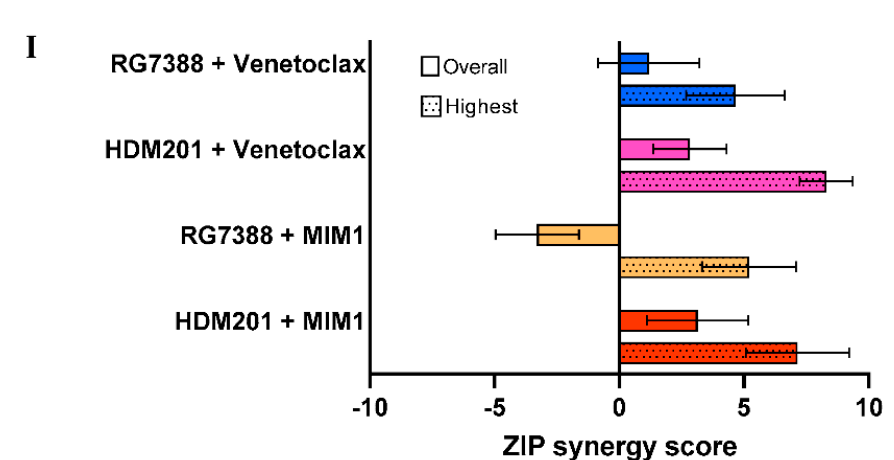
Figure 10. Dose–response curves for single agents, dose–response matrices (inhibition) and syn- ergy maps generated using SynergyFinder for ( A , B ) Venetoclax and RG7388; ( C , D ) Venetoclax and HDM201; ( E , F ) MIM1 and RG7388; and ( G , H ) MIM1 and HDM201. On the synergy maps the areas with the greatest synergy are marked with a square; ( I ) Summary plot displaying the overall and highest synergy scores for each combination as determined by the Zero Interaction Potency (ZIP) Model. MES-SA cells were treated for 72 h and growth inhibition was assessed using the SRB assay. Results were then analysed using SynergyFinder. Data represent three independent repeats with mean ± SEM.